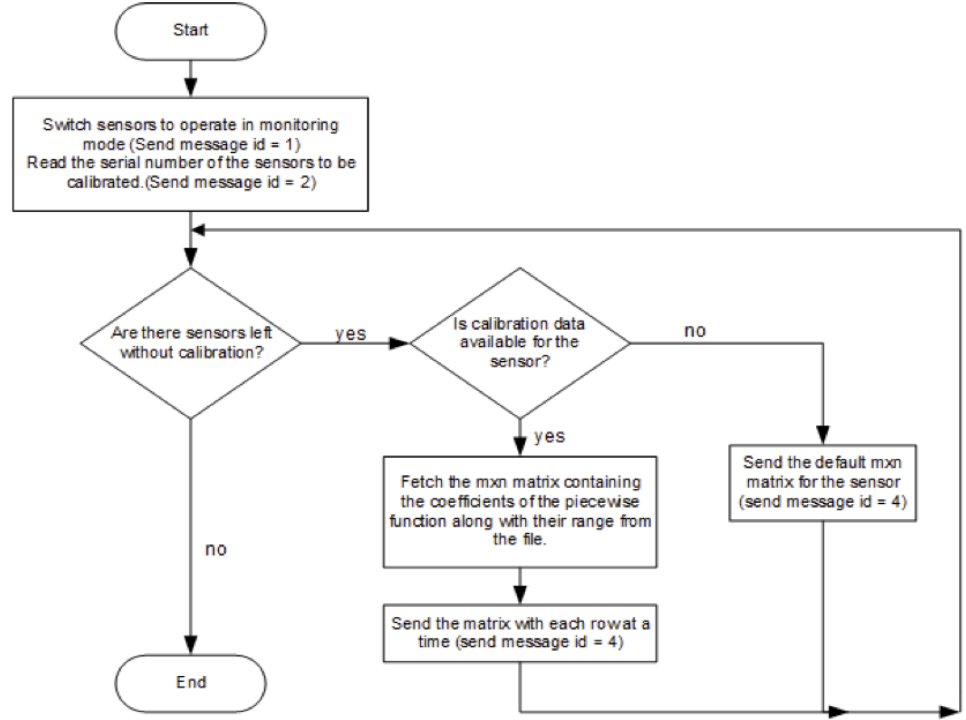
Figure 12. Process of uploading the polynomial coefficients to the sensor node.